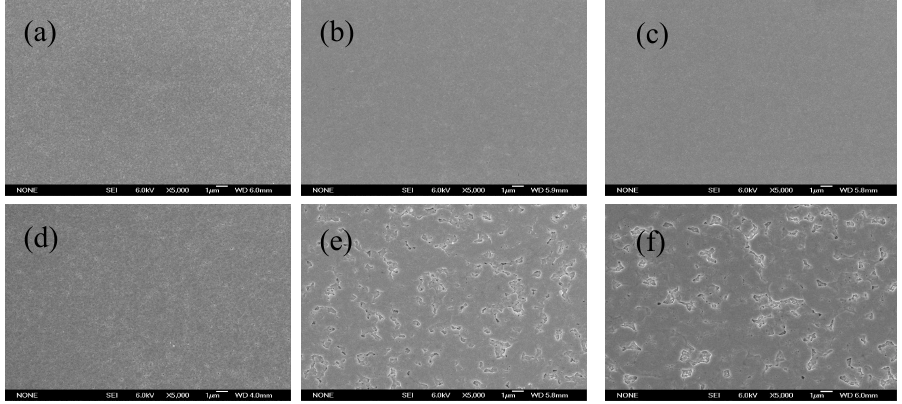
Figure A2. SEM image of MAPbI 3 films at low magnification with different MA treatment times. Processing time: ( a ) 0 s, ( b ) 5 s, ( c ) 10 s, ( d ) 15 s, ( e ) 20 s, ( f ) 30 s.